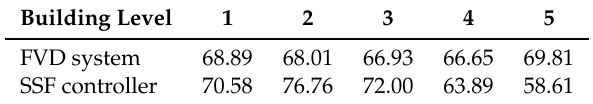
Figure 6. Time-response peak-values. ( a ) Maximum absolute interstory drifts ( absolute total accelerations (m/s 2 ). ( c ) Maximum absolute actuation forces ( Table 4. Interstory-drift peak-value reductions with respect to the uncontrolled